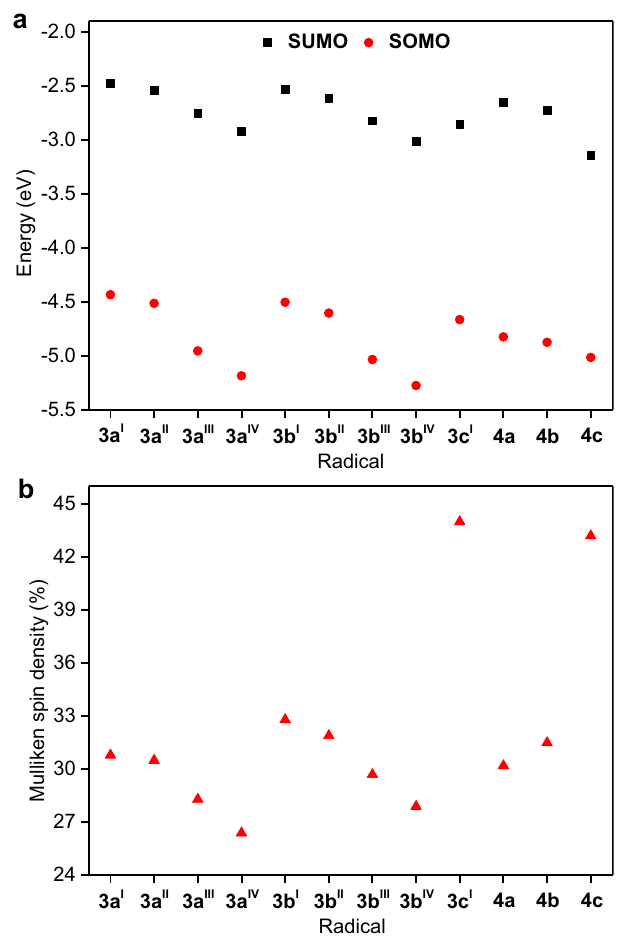
Fig. 4 | Quantum-chemical results for radicals 3a – c and 4a – c. a DFT energies of the SOMO and SUMO frontier orbitals of radicals 3a – c and 4a – c , as calculated at the tuned UB3LYP/6-31G(d) level of theory. SOMO, singly occupied molecular orbital; SUMO, lowest singly unoccupied molecular orbital. b Calculated Mulliken spin densities on carbene carbon atom in radicals 3a – c and 4a – c